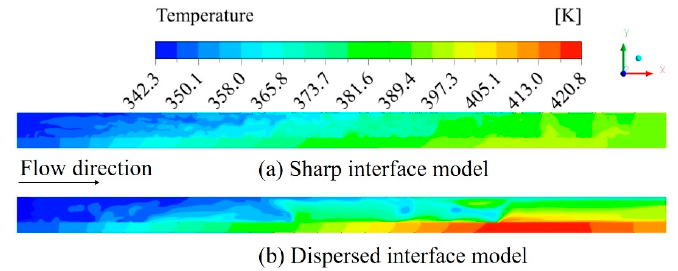
Figure 3. Transient temperature field at the symmetrical section of channel for different interface models.